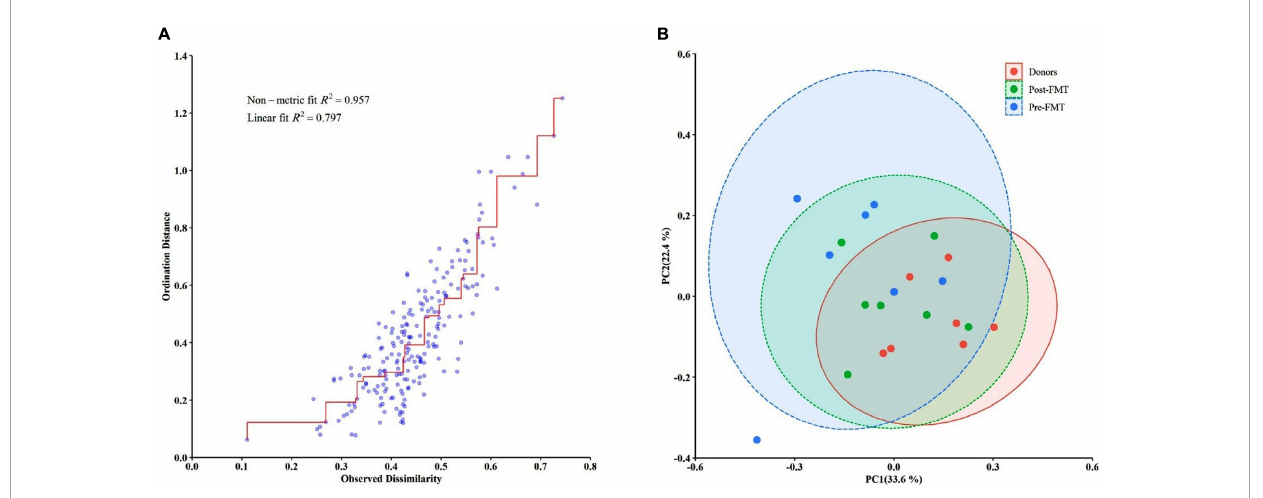
FIGURE6 Differences in the gut microbiota composition of the studied groups using the Bray–Curtis dissimilarity metric plotted in a principal coordinate analysis (PCoA) space. (A) The Bray–Curtis dissimilarity plot. (B) The PCoA comparing the microbial communities from different groups (pre-FMT, post-FMT, and donors). Each circle represents a participant colored according to the studied group. Spearman’s correlation was used for non-parametric analysis.